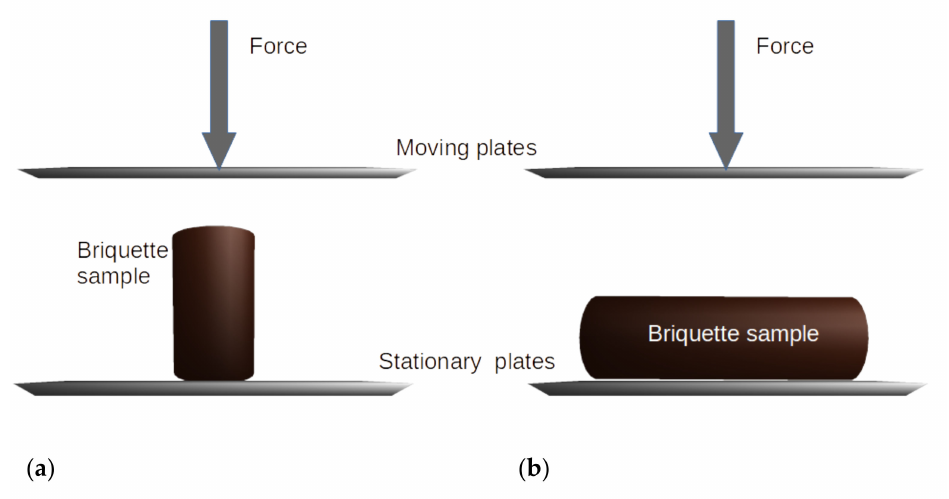
Figure 5. Typical orientation of biomass briquette sample during ( a ) compressive strength, and ( b ) tensile strength